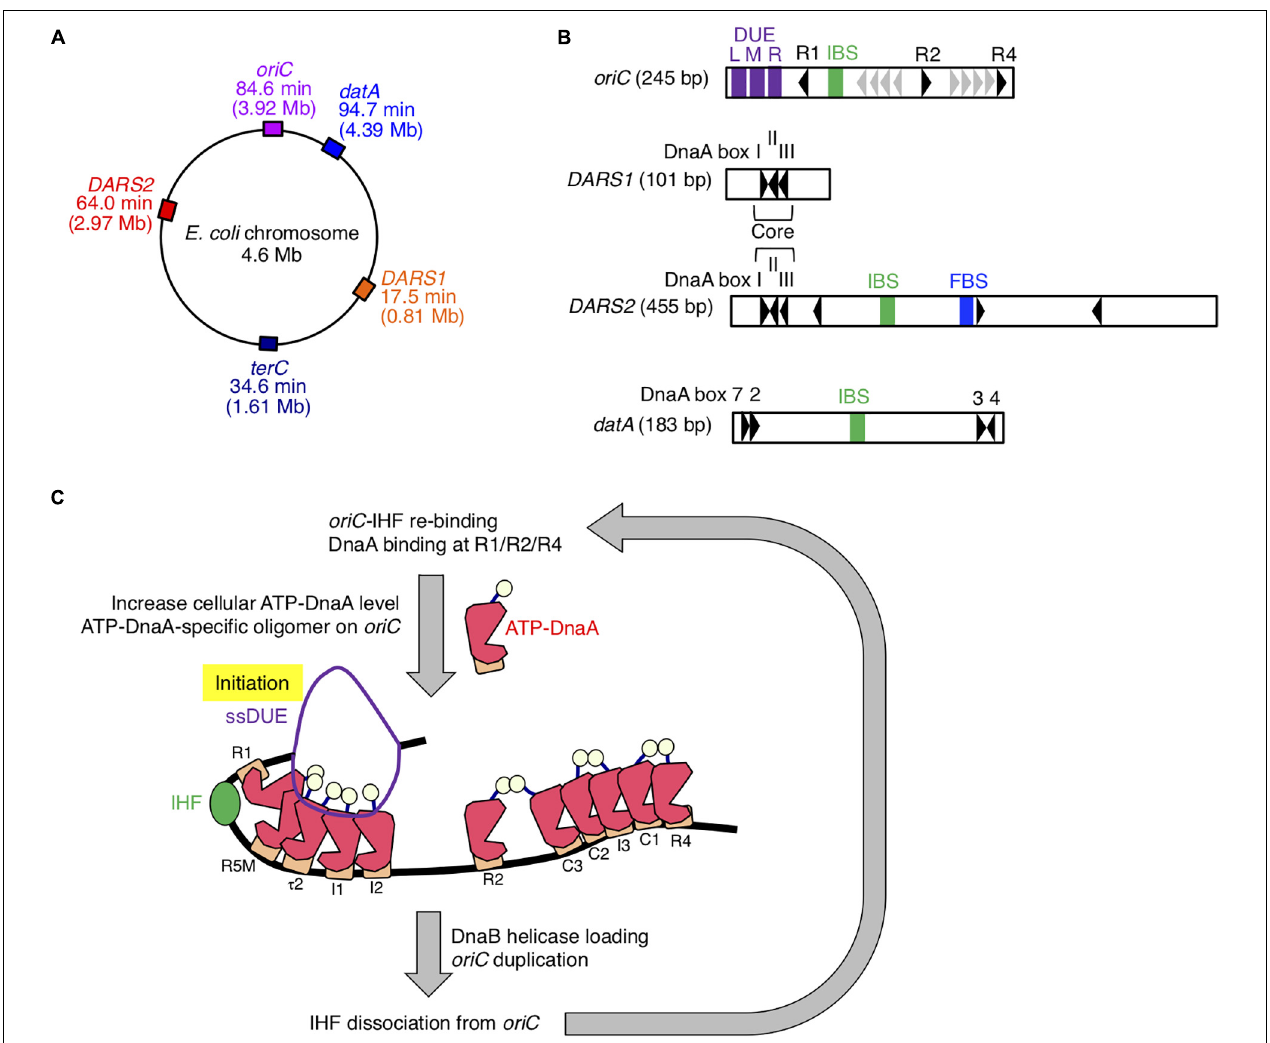
FIGURE 1 | Role of IHF binding at oriC . (A) The locations of oriC , datA , DARS1 / 2 , and TerC loci are indicated on the chromosome. (B) Schematic representation of the structures of oriC , datA , and DARS1 / 2 are described. Black arrowheads represent DnaA-binding sites (DnaA boxes) that match the 9-mer consensus sequence completely or with only a single mismatch. Gray arrowheads in oriC indicate low-affinity ATP–DnaA-binding sites R5, I1–3, τ 2, and C1–3. For simplicity, a non-essential τ 1 site partially overlapping with IHF-interacting region including IHF-binding sequence (IBS; green bars) is omitted (Sakiyama et al., 2017). DnaA boxes 2, 3, 4, and 7 in datA and “Core” DnaA boxes I–III in DARS1 / 2 are essential for their activities. IBS, Fis-binding sequence (FBS; blue bar), and AT-rich repeats L, M, and R (DUE; purple bars) are also indicated. (C) Role and timing of IHF binding at oriC . IHF binds to a unique IBS and bends DNA during the pre-initiation period. At the initiation stage, ATP–DnaA becomes more abundant and forms specific oligomers on oriC . The left DnaA pentamer with bound IHF unwinds the DUE to initiate replication. After replication initiation, IHF quickly dissociates from oriC . DnaA is shown as pink polygon (domain III) with light yellow ball (domain I) and orange rectangle (domain IV). IHF is also shown as a green